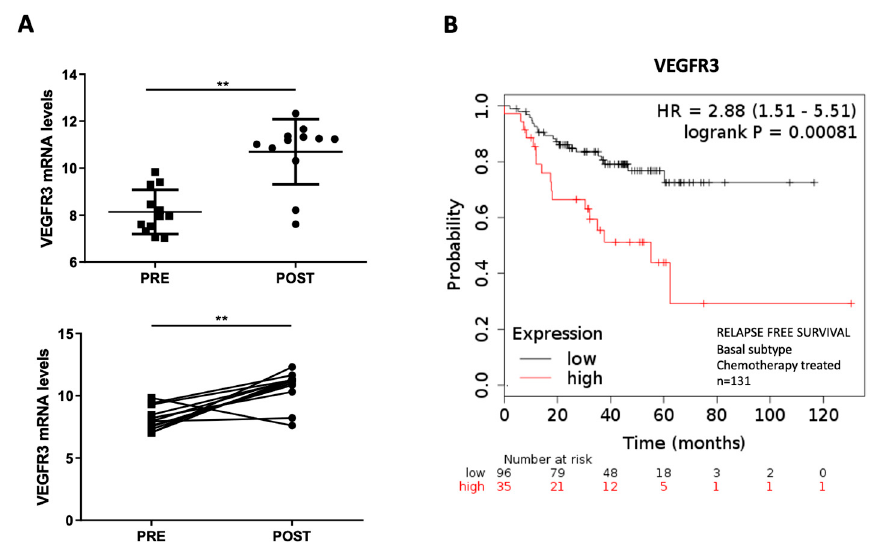
Figure 3. VEGFR3 expression analysis and prognostic value in triple-negative breast cancer patients. The VEGFR3 mRNA expression was analyzed by RT-qPCR in 24 samples from anthracycline-treated TNBC patients. Paired samples from the same patient before (PRE, n = 12) and after (POST, n = 12) anthracycline chemotherapy treatment were included. GAPDH was used as endogenous control. ** p < 0.01 ( A ). A cohort of 131 BC basal patients treated with chemotherapy was analyzed using the Kaplan–Meier Plot tool with a 120-month follow-up for VEGFR3 mRNA with auto-selected best cut-off for low (black) and high (red) expression ( B ).